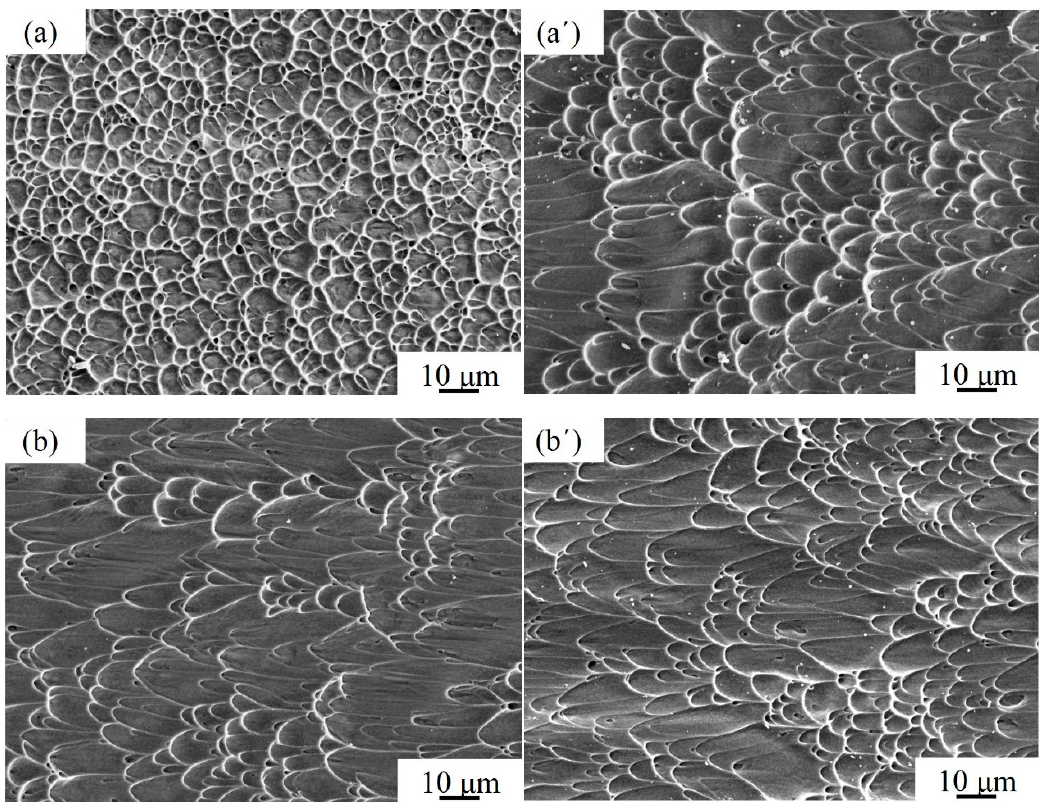
Figure 11. Microscopic morphology of the shear fracture surfaces of the bond ( left figures ) and base alloy ( right figures ) at different times: ( a , a ′ ) 1 min; ( b , b ′ ) 10 min. (The shearing direction is horizontal.).